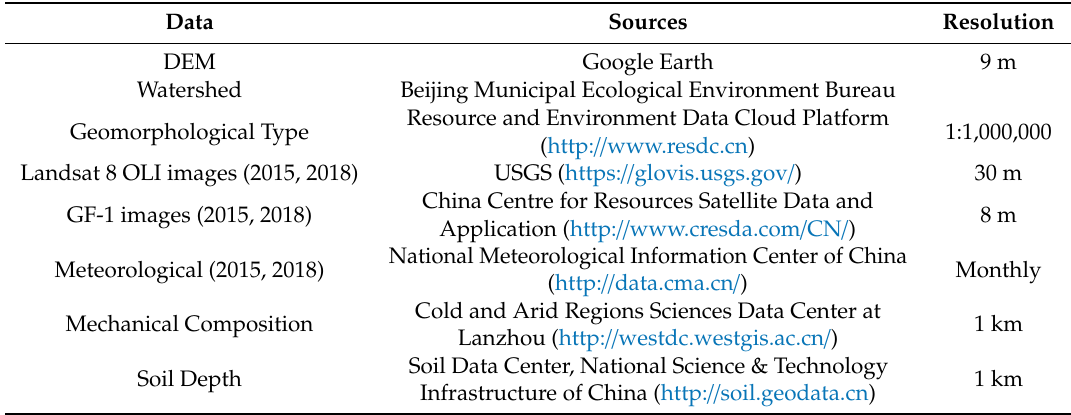
Table 1. Data requirements and